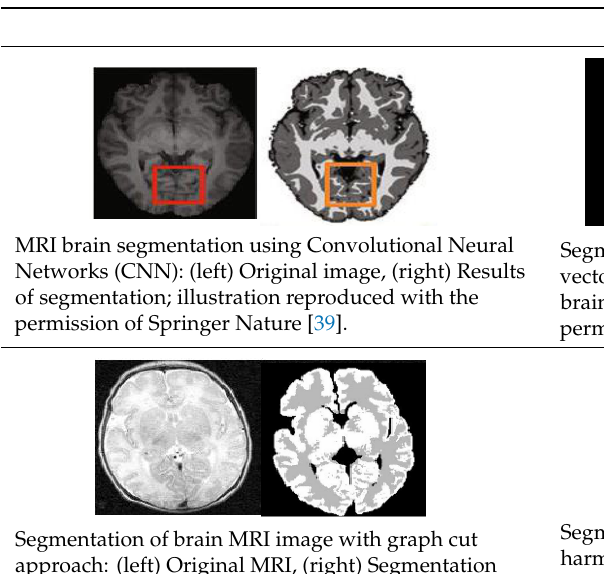
Table 2. Visual illustration of the MRI brain segmentation using some techniques described in the literature: The examples illustrate the results obtained with the techniques classified in the five categories, namely: (A) Region approach, (B) form approach, (C) graph theory approach, (D) structural approach and (E) contour approach.